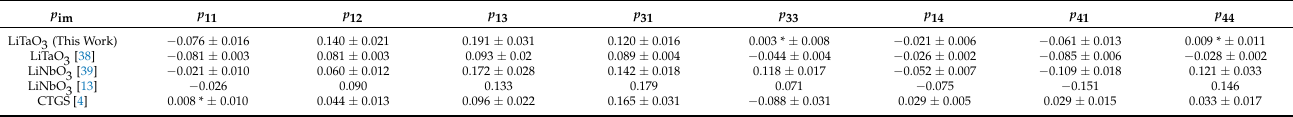
Table 6. All independent elasto-optic p in coefficients of LiTaO 3 , LiNbO 3 and CTGS crystals ( λ = 632.8 nm, T = 20 ◦